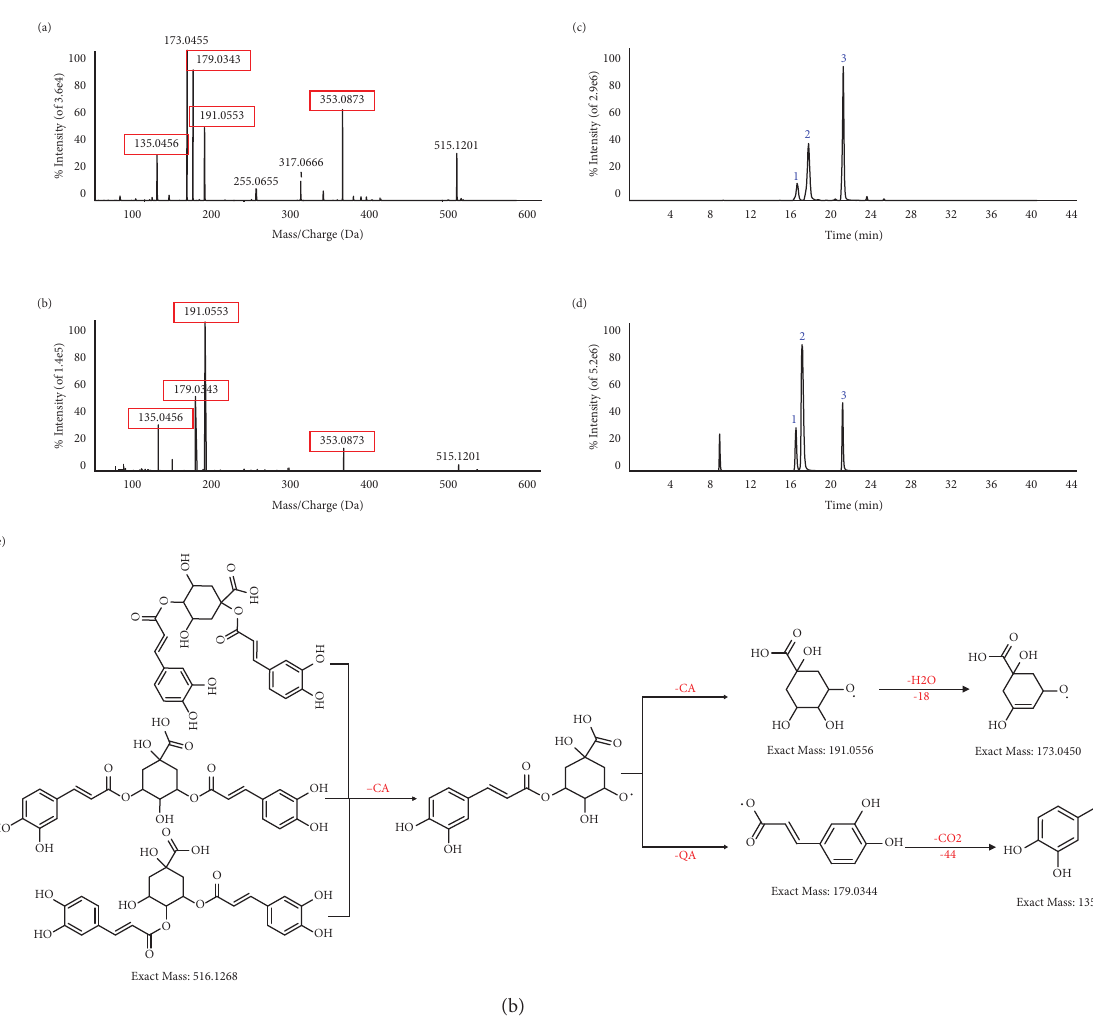
Figure 6: (a) Chlorogenic acid (1), neochlorogenic acid (2), and cryptochlorogenic acid (3). (b) 1,4-Dicaffeoylquinic acid (1), 3,4-dicaffeoylquinic acid (2), and 3,5-dicaffeoylquinic acid (3) (A: MS/MS of IRC; B: MS/MS of standard compounds; C: UV of IRC; D: UV of standard compounds; E: mass spectrum fracture